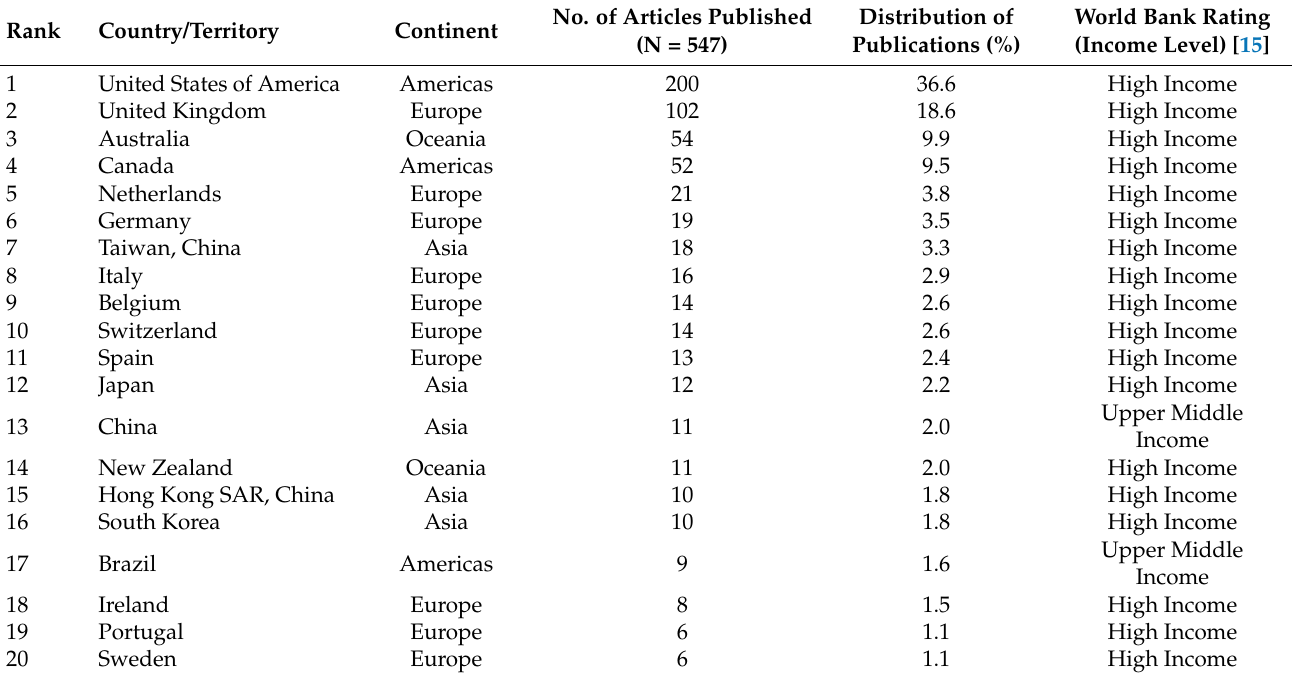
Table 1. Top 20 Countries with the most relevant publications on